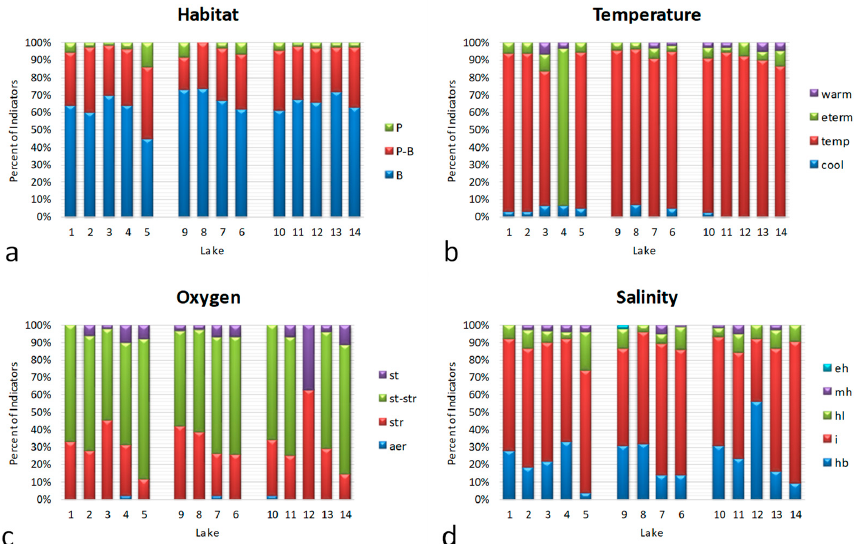
Figure 2. Bioindicator distributions in the 14 studied water bodies: ( a ) habitat preferences (P—planktonic, P-B—plankto-benthic, B—benthic); ( b ) temperature (cool—cool water, temp—temperate, eterm—eurythermic, warm—warm water); ( c ) oxygen (st—standing water, str—streaming water, st-str—low streaming water, aer—aerophiles); ( d ) salinity (hb—oligohalobes–halophobes, i— oligohalobes–indi ff erents, hl—halophiles; mh—mesohalobes, eh—euhalobes). Ecological groups in each fi gure are placed in ascending order of the environmental parameter.